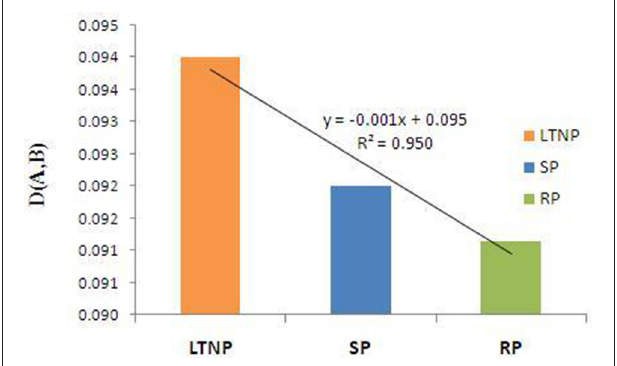
FIGURE 4 | Similarity index [D(A,B)] of env genes (LTNP, SP, and RP) with respect to human host. Orange bar refers to similarity index value [D(A,B)] of Long term non-progressor (LTNP) sequences. Blue bar represents the similarity index value [D(A,B)] of the Slow progressor (SP) sets. Green bar depicts the similarity index value [D(A,B)] of the Rapid progressor (RP) sequences.